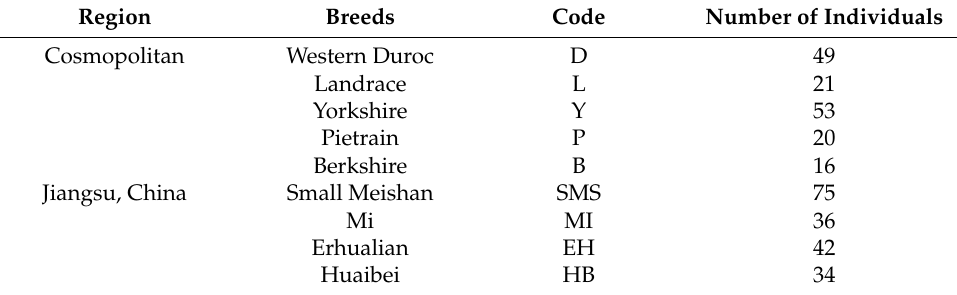
Table 1. Breeds and Sample